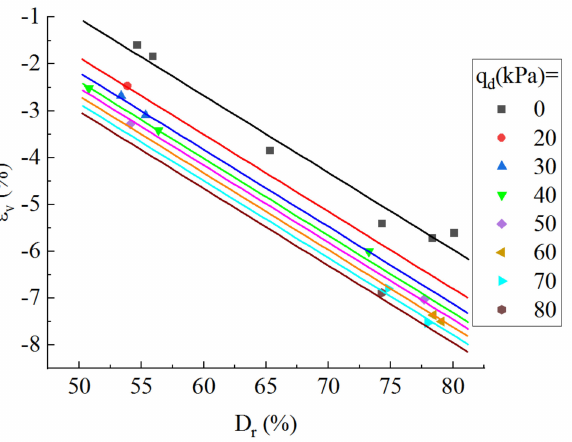
Figure 9. Relationship of volume strain (measured at ε a = 25%) and deviatoric stress